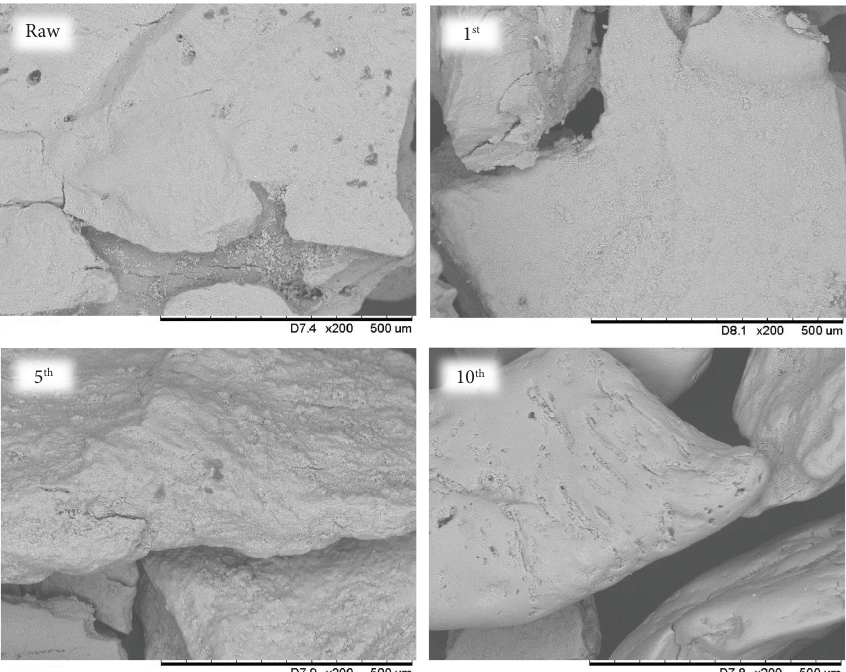
Figure 7: SEM micrographs (200x) of raw and regenerated bone chars. Samples were regenerated with 0.075 mol/L